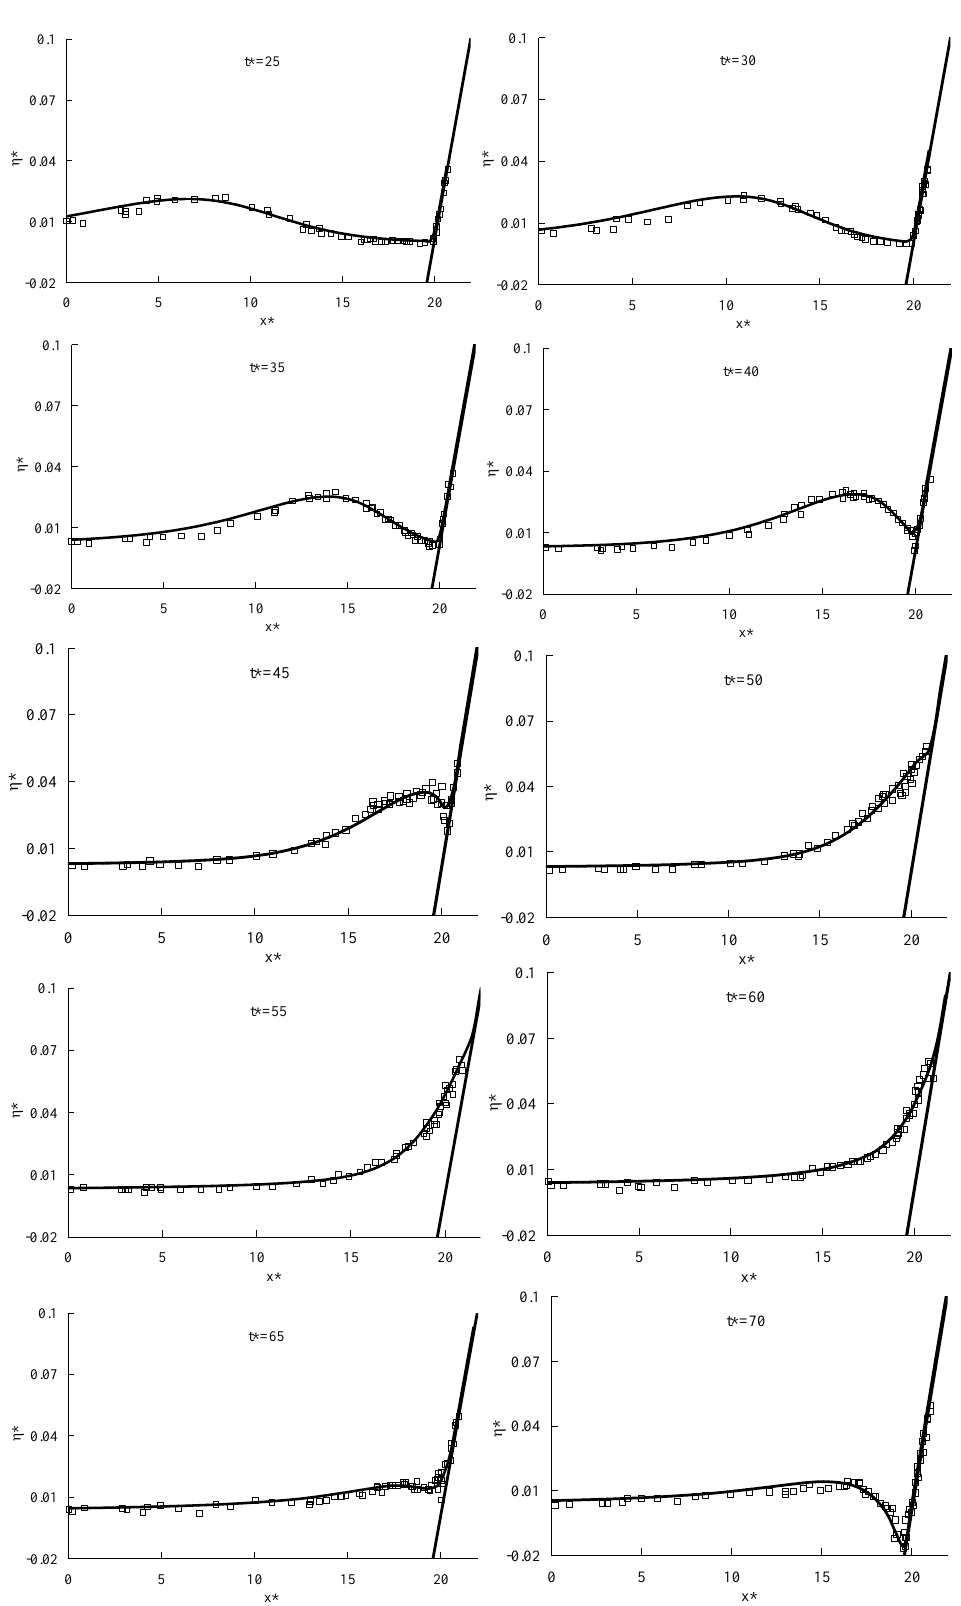
Figure 2. Sketch of the solitary wave propagation on a sloping beach.